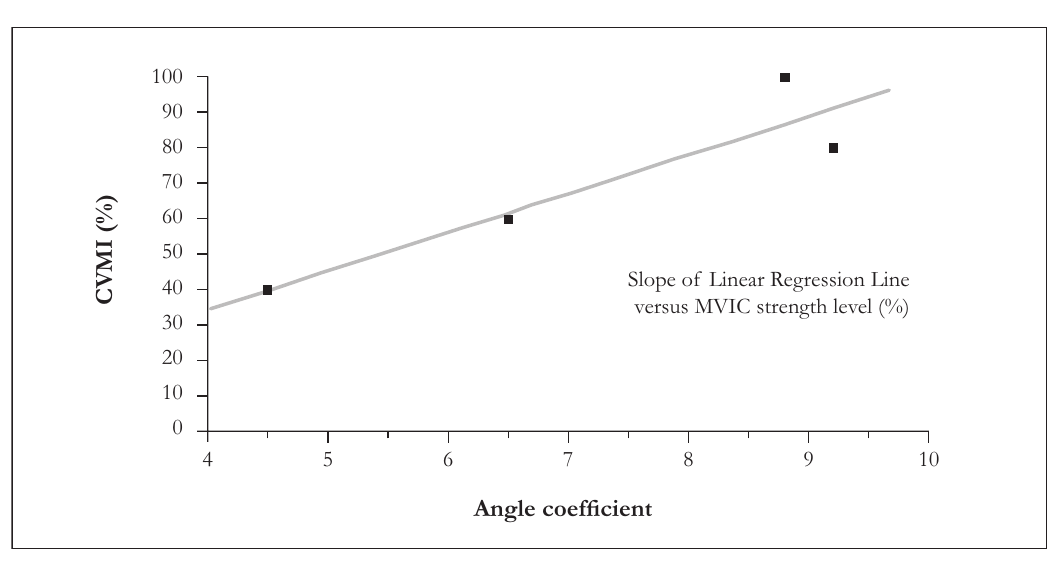
Figure 3 - Slope of linear regression line (determined by Pearson’s test) for median frequency of each strength level measured for the Rectus femoris of Volunteer 1 (abscissa axis) crossed with respective strength levels (ordinate axis). The linear regression line obtained by the slope of each strength level (100, 80, 60, 40% of MVIC) establishes a new linear regres- sion line, which crosses the ordinate axis (percentage of strength level), demonstrating the fatigue index for the muscle